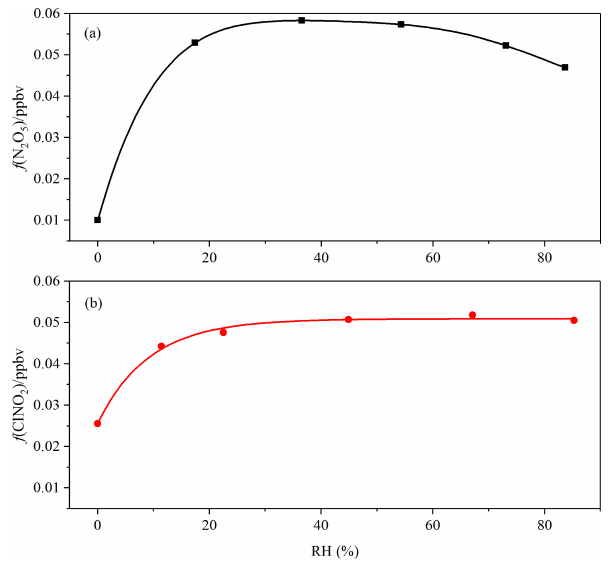
Figure A1. CIMS sensitivities as a function of RH for (a) N 2 O 5 and (b) ClNO 2 .